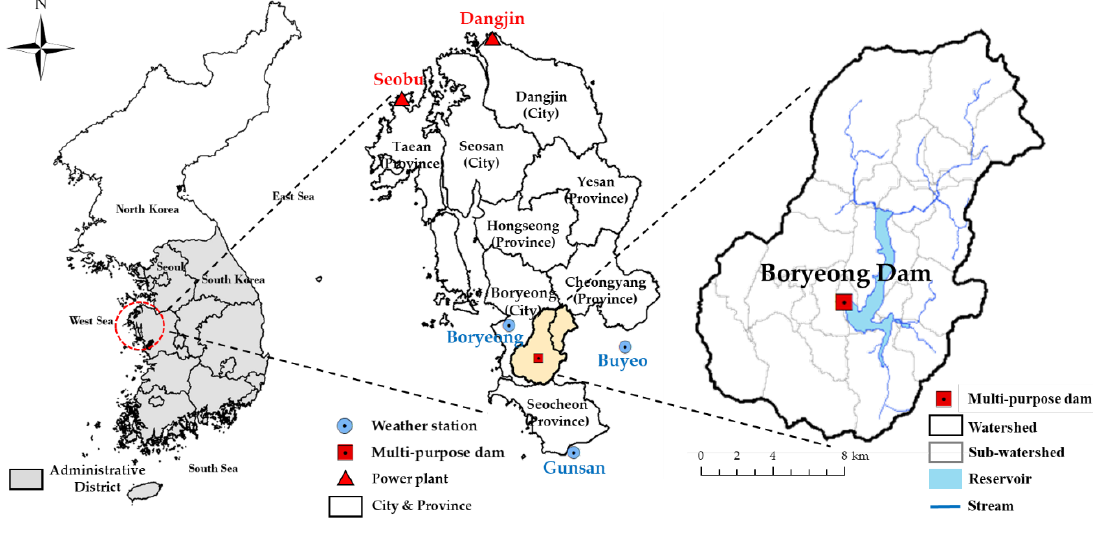
Figure 1. The studied Boryeong Dam watershed.